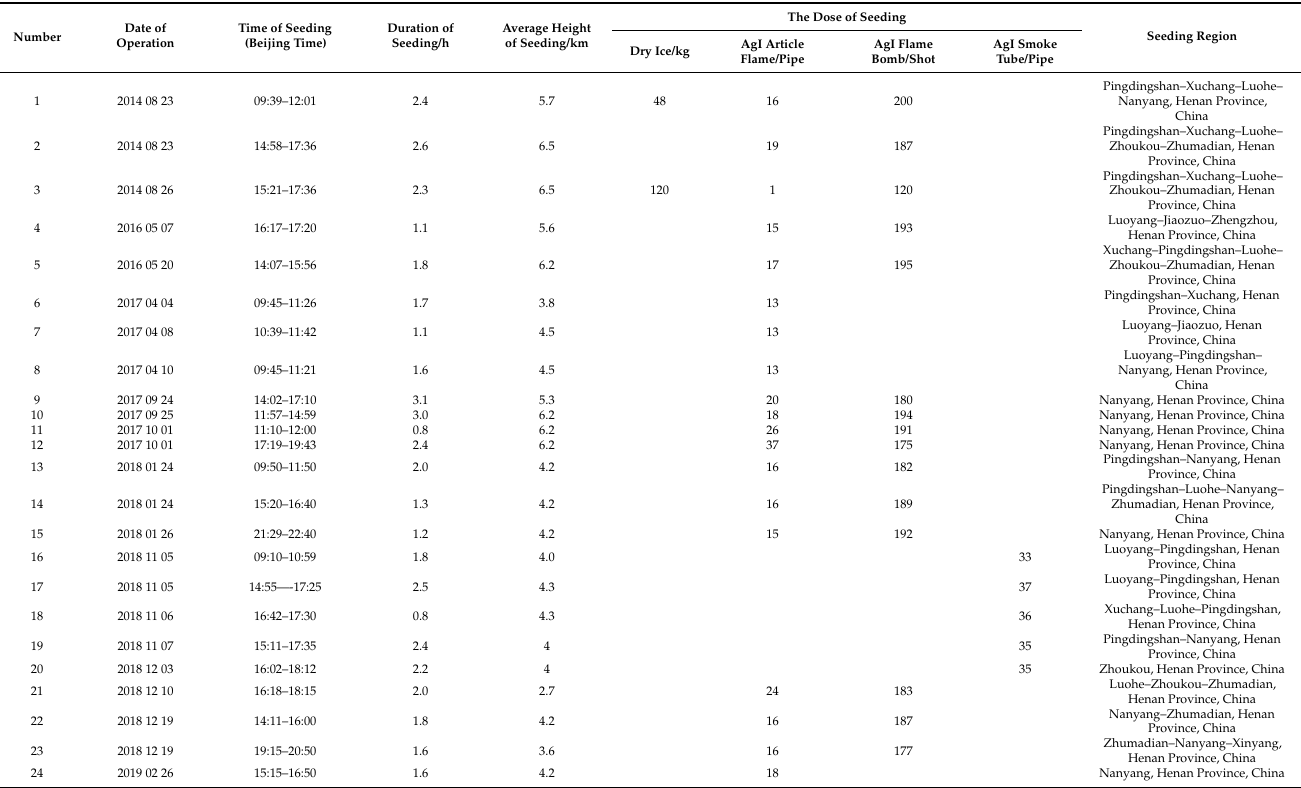
Table 2. Information of 24 aircraft precipitation enhancement operations in Henan from 2014 to